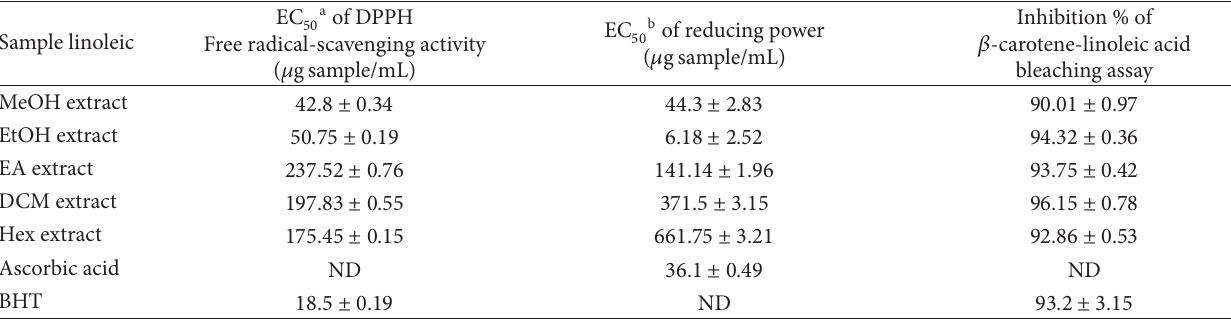
Table 2: Antioxidant activities of E . hirta aerial extracts.